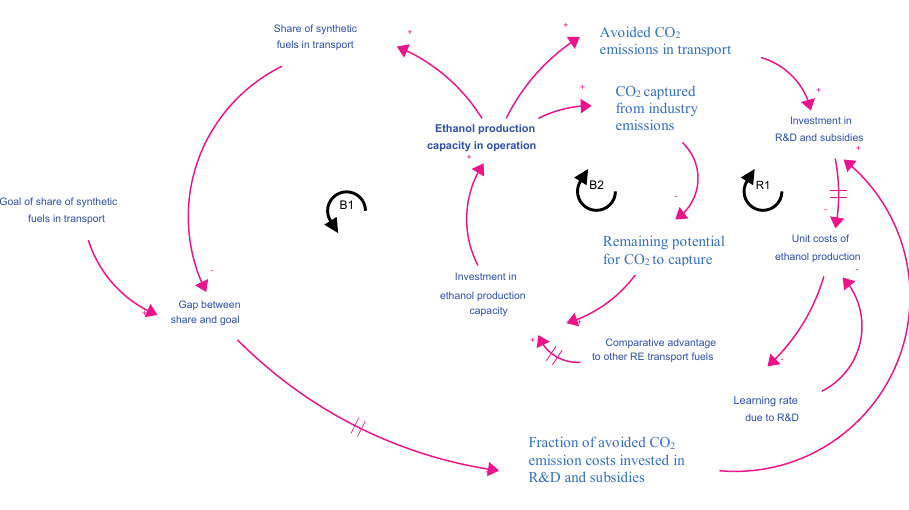
Fig. 1. Causal loop diagram (CLD) of the model (R&D – research and development; RE – renewable energy; R1 – reinforcing loop No. 1; B1 – balancing loop No. 1; B2 – balancing loop No. 2). ‘Plus sign’ means that increase/decrease in cause results in increase/decrease in effect relative to what otherwise would have been if everything else remains the same. ‘Minus sign’ means that increase/decrease in the cause results in decrease/increase in the effect relative to what otherwise would have been if everything else remains the same. Two vertical lines on the arrows indicate that a time span between the cause and effect may be relatively